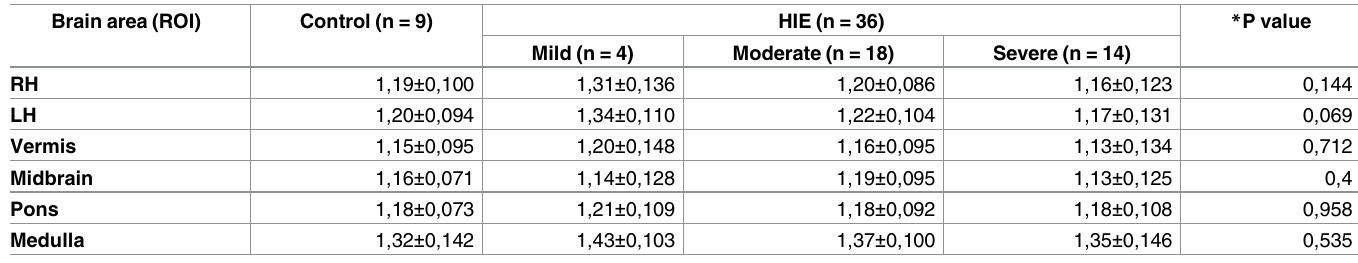
Table 2. The ADC mean (SD) x10 -3 /mm 2 /second at first MRI in six regions of interest (ROIs) in all infants. Brain area